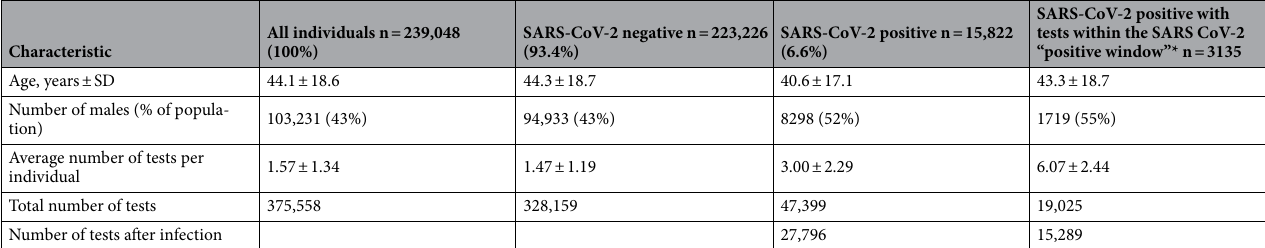
# of patients with severe condition